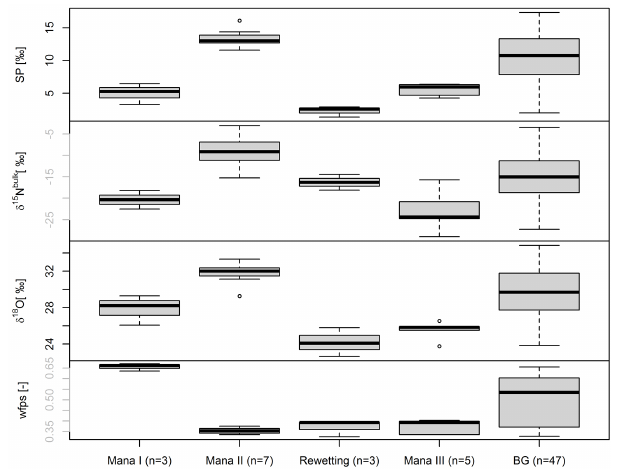
Figure 5. Maps of SP in relation to NH + tion to wfps and soil temperature. The size of the points is inversely scaled to Keeling plot intercept standard error so that biggest points are those with lowest uncertainty.